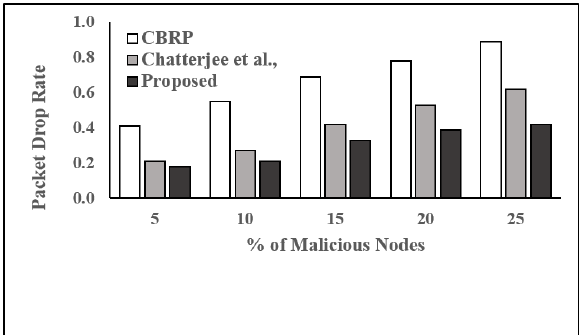
Figure 5. Packet delivery fraction vs. % of malicious nodes.